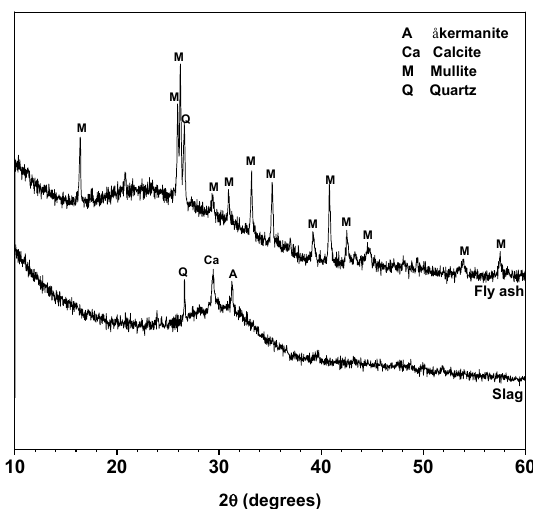
Figure 1. XRD patterns of fly ash and slag. Phases identified: åkermanite (A), Ca 2 MgSi 2 O 7 , PDF No. 74-990; Calcite (Ca), CaCO 3 , PDF No. 83-1762; Mullite (M), Al 5.65 Si 0.35 O 9.175 , PDF No. 82-1237 and Quartz (Q), SiO 2 , PDF No. 74-1811.